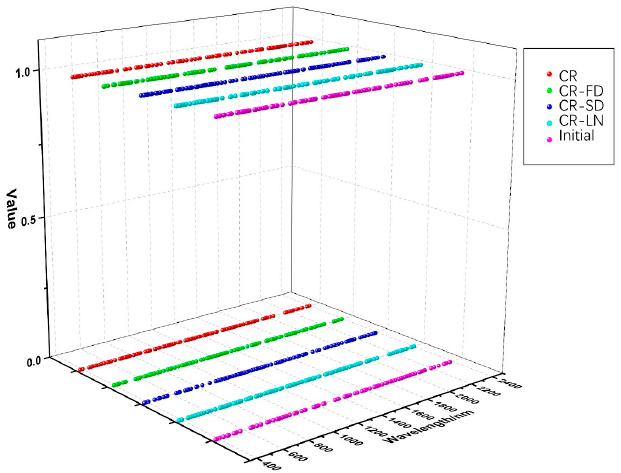
J. Imaging 2023 , 9 , x FOR PEER REVIEW Figure 4. Distribution of bands marked using GA. Figure 4. Distribution of bands marked using GA.